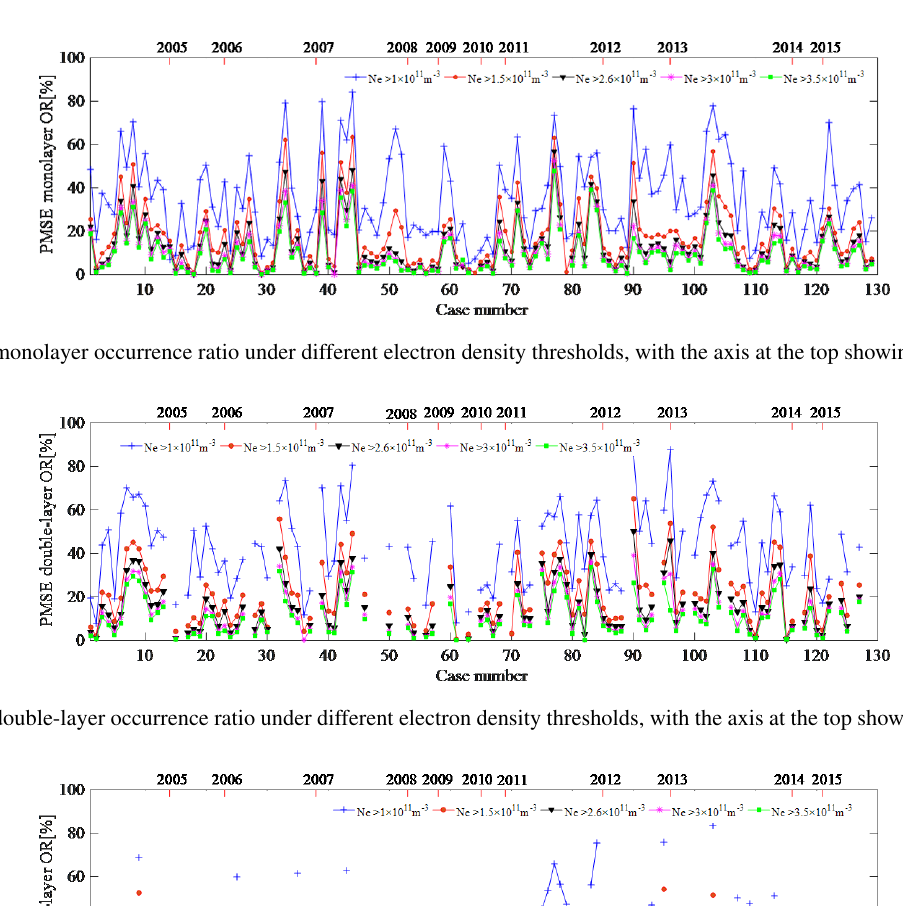
Spearman’s rank correlation coefficient is a measure